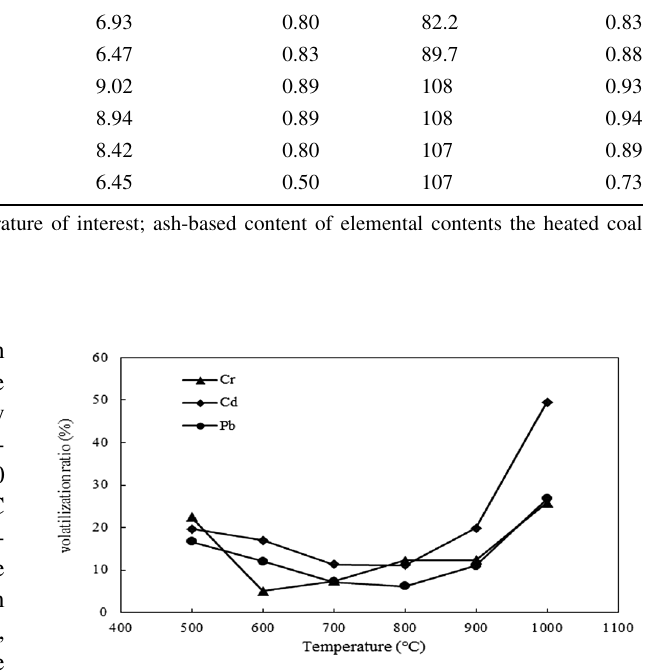
Fig. 1 Volatilization ratios of Cr, Cd, and Pb in stone coal under different combustion